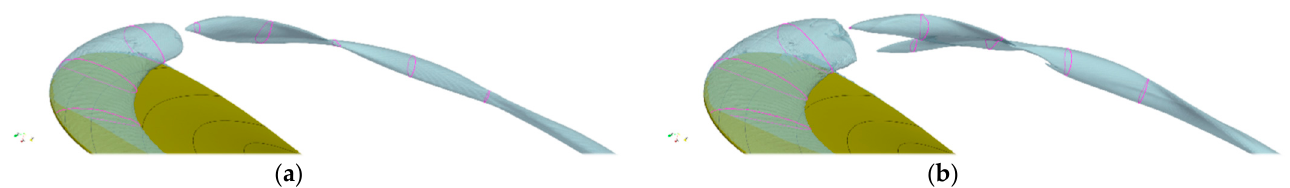
Figure 14. Newcastle. C2 tip vortex cavitation isosurface with two stations and two different refinement levels: ( a ) Base a priory; ( b ) 8x higher cell count in the tip vortex region.